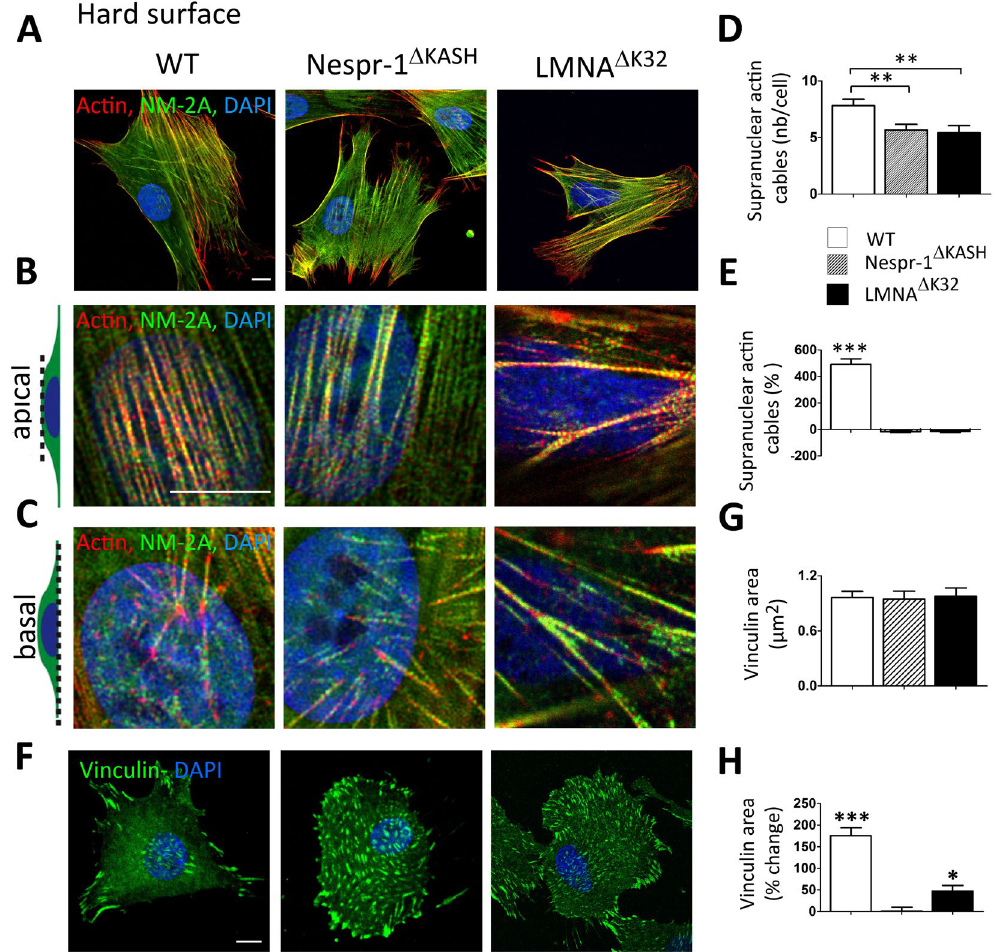
Figure 7. Impaired ability to sustain high external force in Nespr-1 Δ KASH and LMNA Δ K32 cells. ( A ) Confocal images of WT, Nespr-1 Δ KASH and LMNA Δ K32 myoblasts on fibronectin-coated rigid matrix (glass) and stained for F-actin (phalloidin, red) and non-muscle myosin IIA (NM-2A, green). Nuclei are stained with DAPI (blue). Scale bar: 10 µ m. ( B , C ) Zoom-in of actin cytoskeleton in the perinuclear regions. Confocal images were taken at the apical ( B ) and basal ( C ) surface of the cell. ( D , E ) Supranuclear actin cable number on hard surface in WT, Nespr-1 Δ KASH and LMNA Δ K32 myoblasts. Values expressed as absolute values ( D ) and as percent changes versus values obtained at 12 kPa ( E ). Values are means ± SEM. n ≥ 20 in WT, Nespr-1 Δ KASH and LMNA Δ K32 myoblasts, *** p < 0.01 vs WT. Only significant difference is figured ( F – H ) Cell matrix adhesions on hard surface. ( F ) Confocal images of WT, Nespr-1 Δ KASH and LMNA Δ K32 myoblasts on hard matrix (glass) and stained with antibody against vinculin (green). Nuclei are stained with DAPI (blue). Scale bar: 10 µ m. ( G , H ) Histograms of vinculin area in WT, Nespr-1 Δ KASH and LMNA Δ K32 myoblasts, expressed as absolute values ( G ) and as percent changes versus values obtained at 12 kPa ( H ). At least 50 cells of each type were analysed. * p < 0.05 and *** p < 0.001 compared with corresponding value obtained on 12 kPa substrate. Only significant difference is